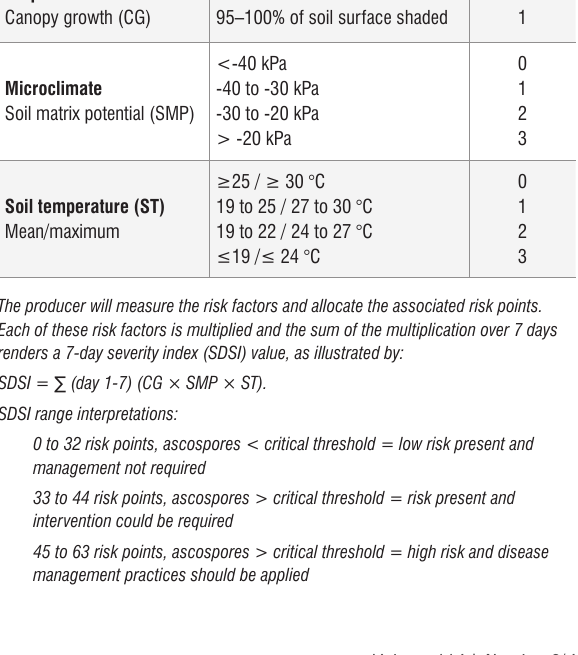
Risk factor Possible answers Points More than 6 years Number of years since last oilseed rape crop